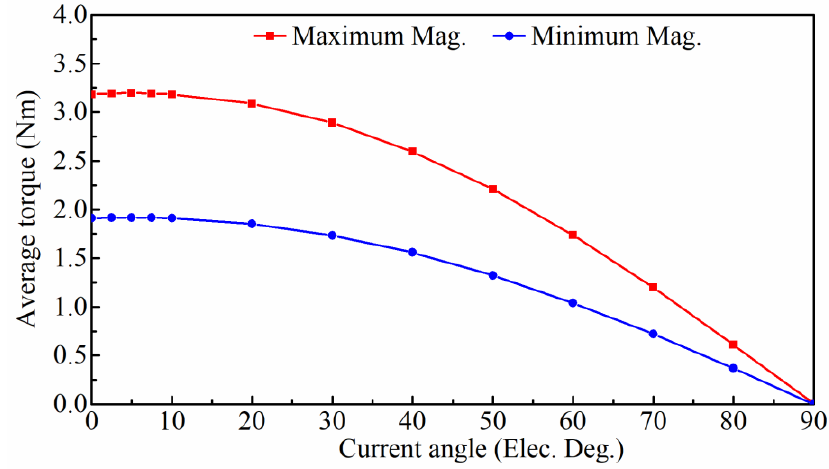
Figure 13. Average torque versus current angle in the maximum and minimum magnetization states.